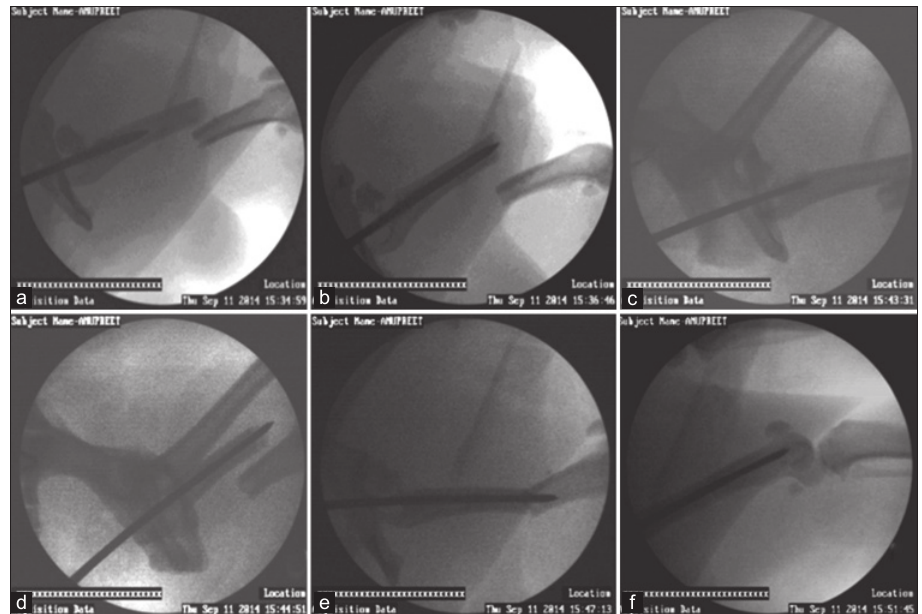
Figure-5: C-arm guided end threaded intramedullary pinning in femur. (a) Insertion of simple Steinmann pin into the proximal bone fragment, (b) Complete reaming of the proximal bone fragment using Simple Steinmann pin, (c) Insertion of end threaded intramedullary pin into the proximal bone fragment after withdrawing out the Simple Steinmann pin, (d) End threaded pin at the fracture site of femur, (e) Toggling of the fractured bone fragments to reduce the fracture, (f) Seating the pin into the distal bone fragment.